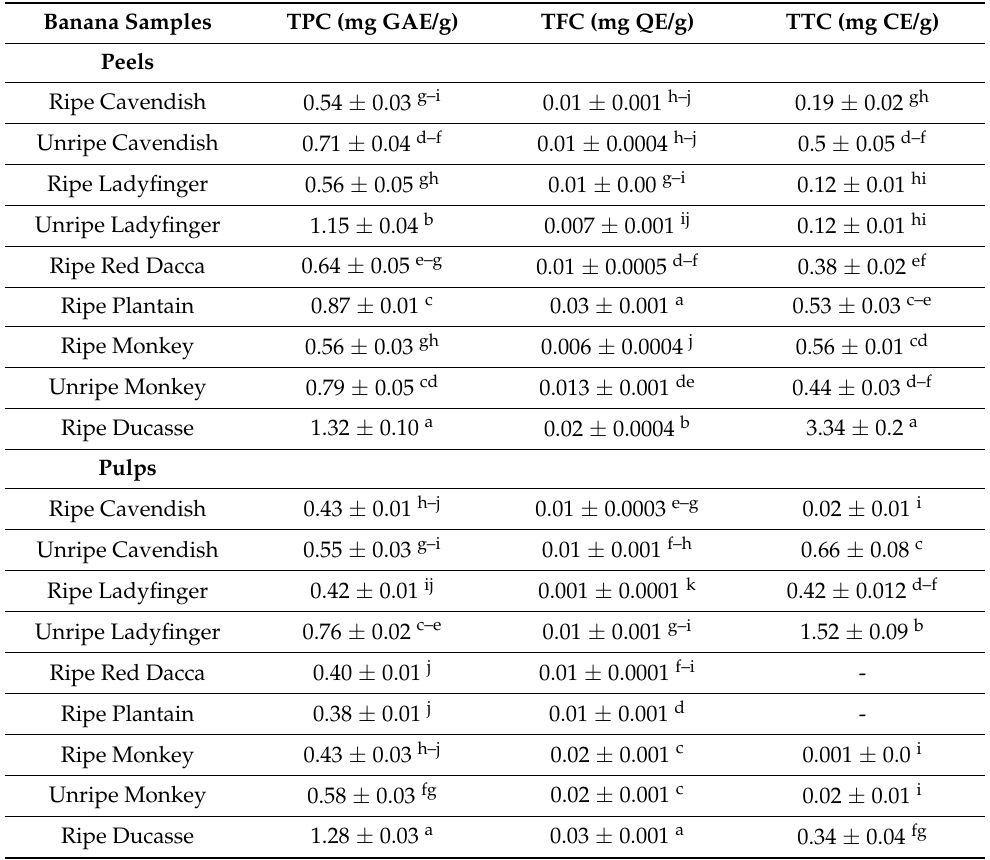
Table 1. Polyphenol contents of six Australian grown